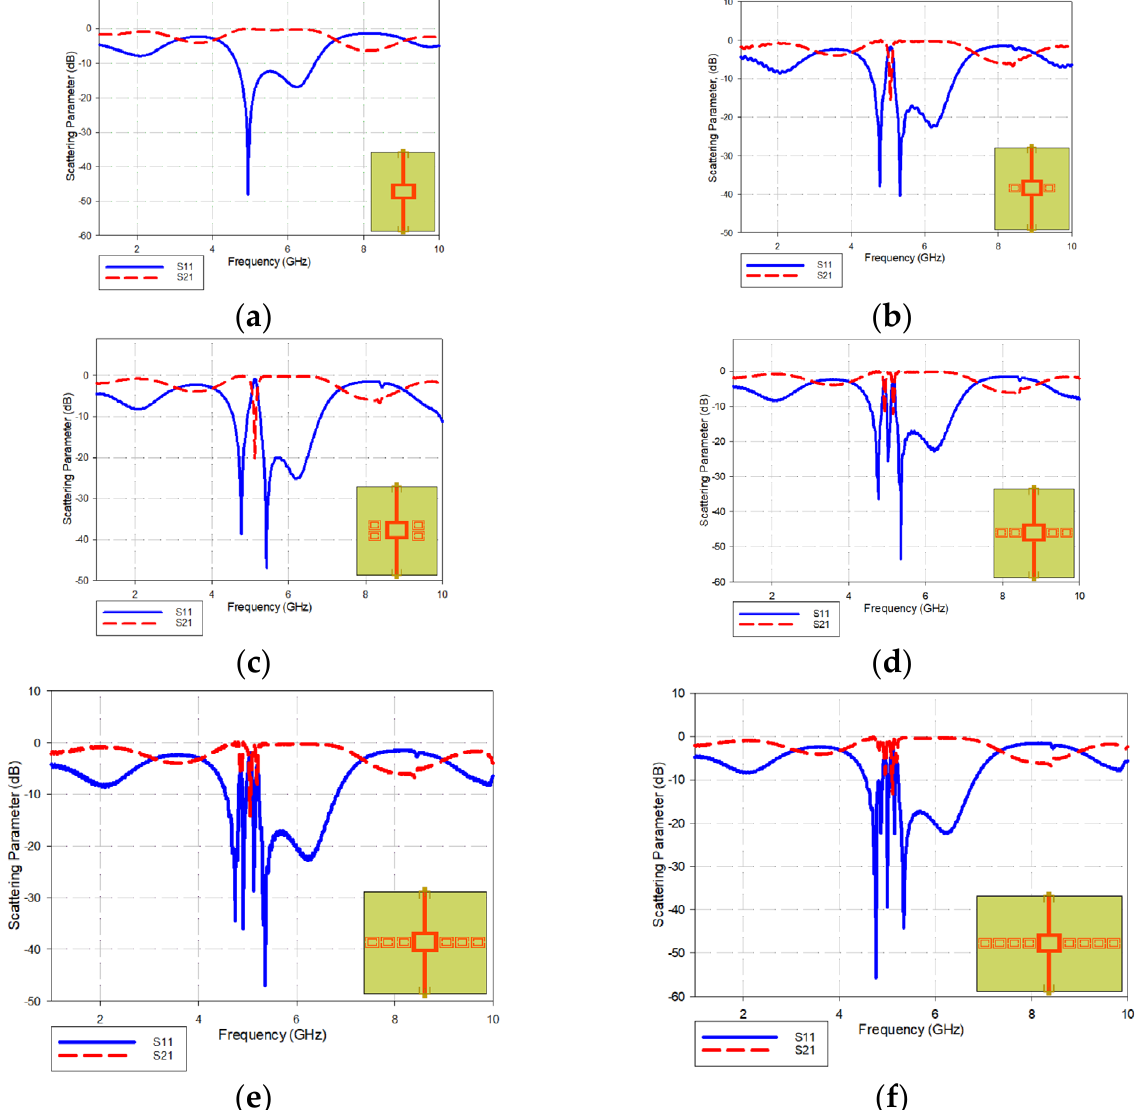
Figure 12. S-parameter response of ( a ) without D-SRR, ( b ) 2 D-SRRs, ( c ) 4 vertical D-SRRs, ( d ) 4 horizontal D-SRRs, ( e ) 6 horizontal D-SRRs, ( f ) 8 horizontal D-SRRs.